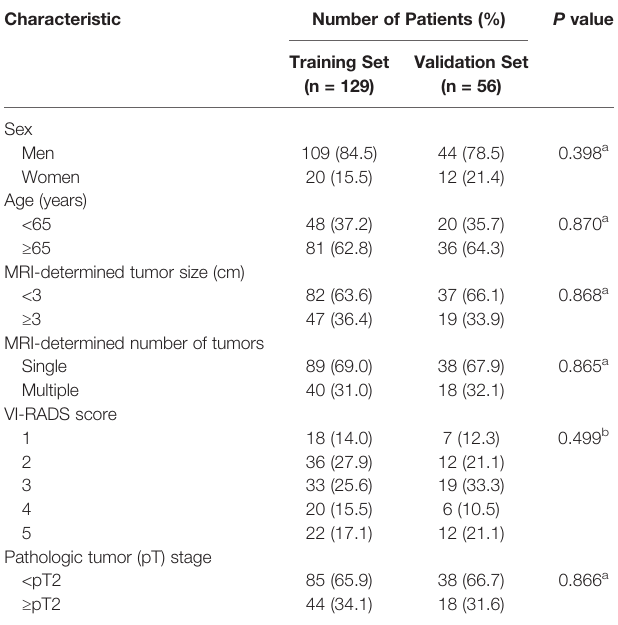
TABLE 1 | Baseline patient